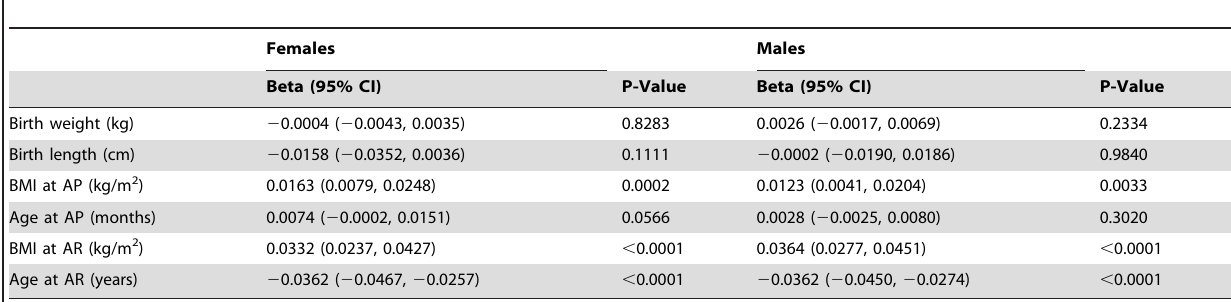
Table 3. Cross-sectional association analysis results for birth measures, BMI and age at adiposity peak (AP) and BMI and age at adiposity rebound (AR) in the ALSPAC and Raine